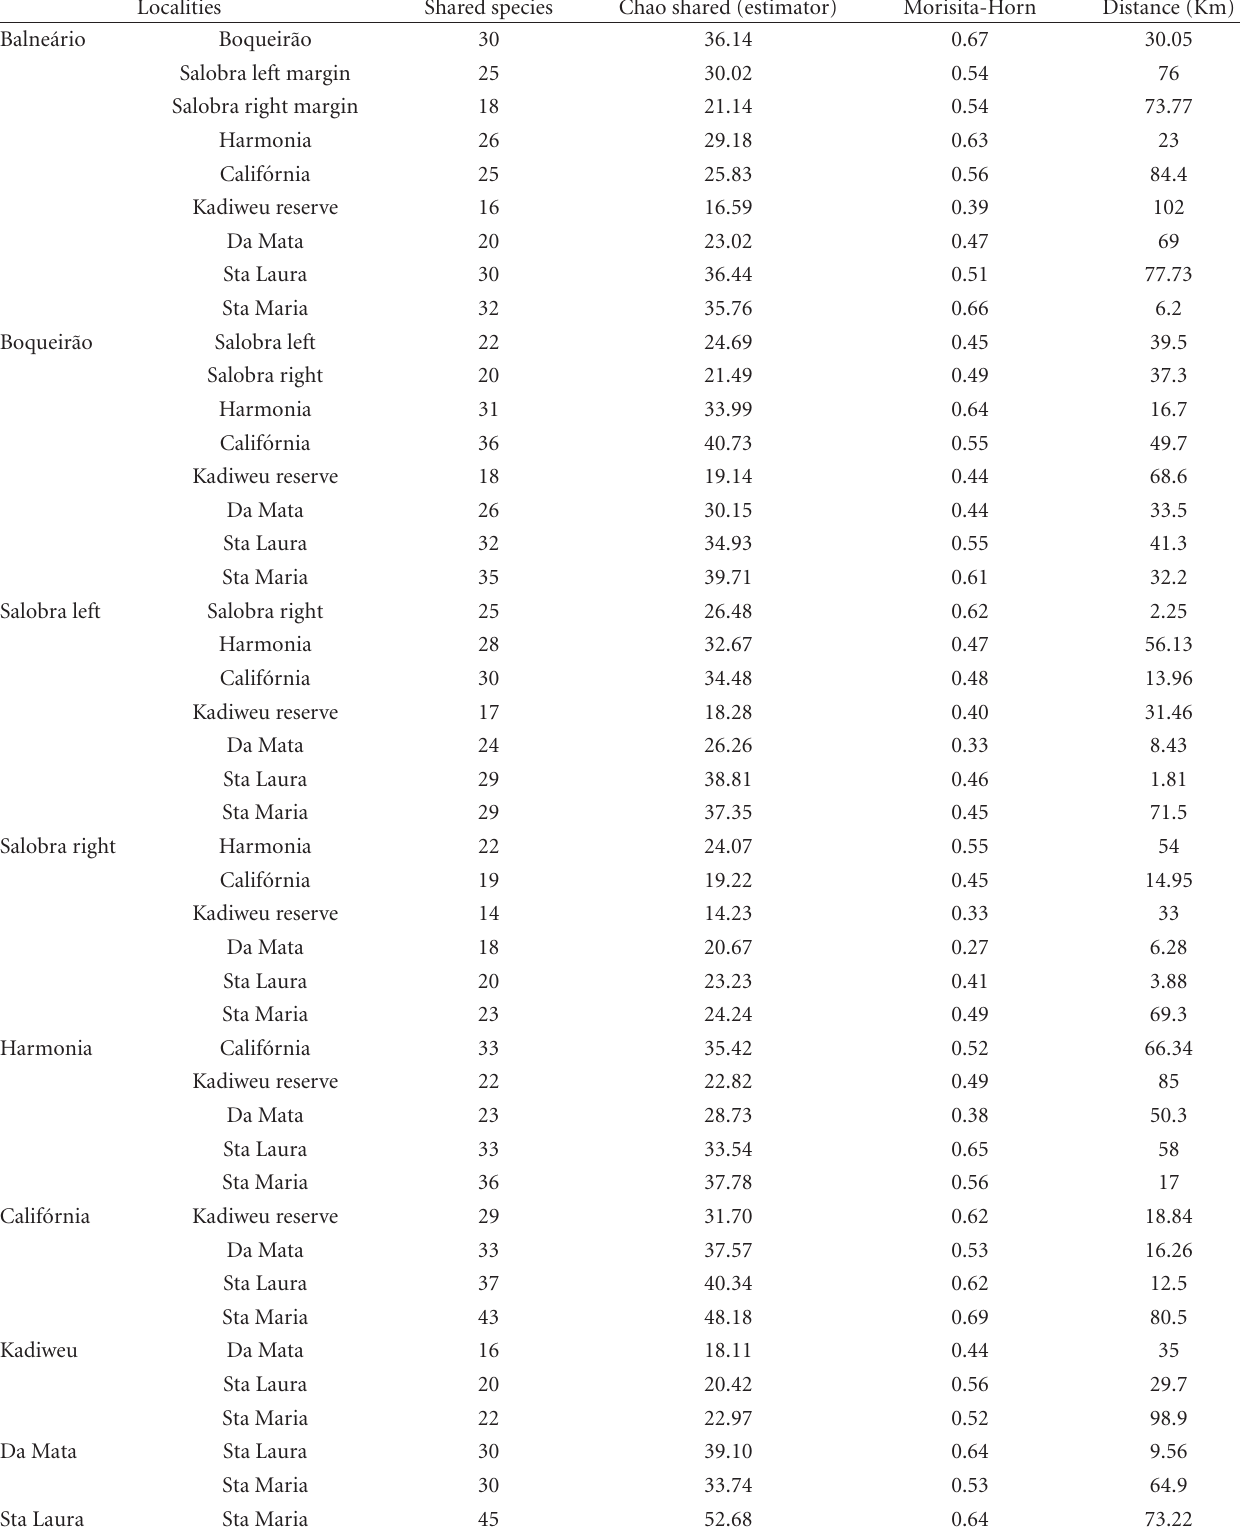
Table 4: Similarity analysis, richness, species shared and distance between sample sites in a pairwise comparison of the leaf-litter ant assemblages from Serra da Bodoquena,